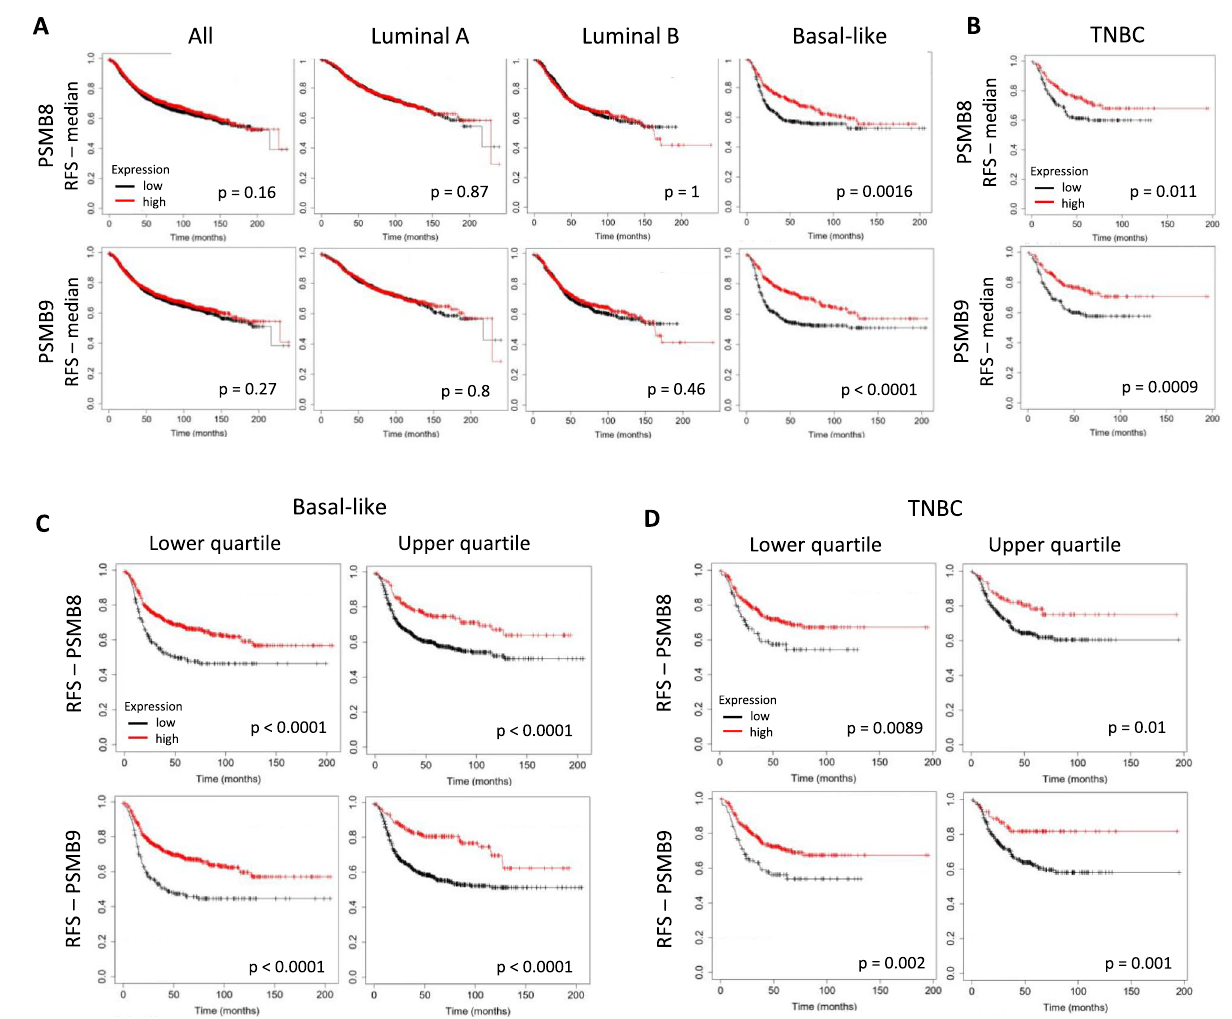
Figure 1. High PSMB8 and PSMB9 mRNA expression is associated with better prognosis in basal-like breast cancer and TNBC. RFS according to PSMB8 and PSMB9 expression of ( A ) all breast cancer patients, as well as for the luminal A, luminal B, basal-like breast cancer or ( B ) TNBC subtypes specifically. The groups were divided according to their median mRNA expression. The same analysis was performed according to upper and lower quartiles of expression for ( C ) basal-like breast cancer, as well as ( D ) TNBC patients. The red and black lines correspond to high and low expression, respectively. Statistical analyses by Logrank test: differences are considered statistically significant when p <